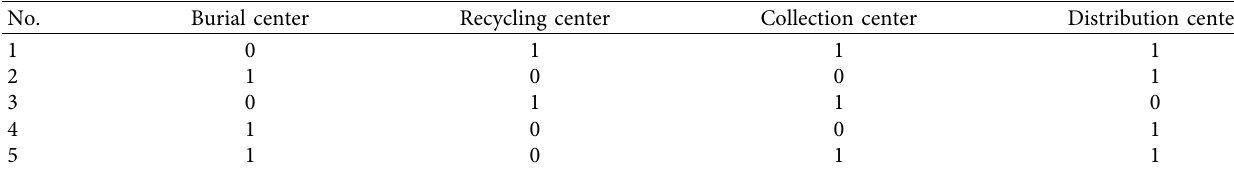
Table 8: Variable values of location of distribution, collection, recycling, and burial